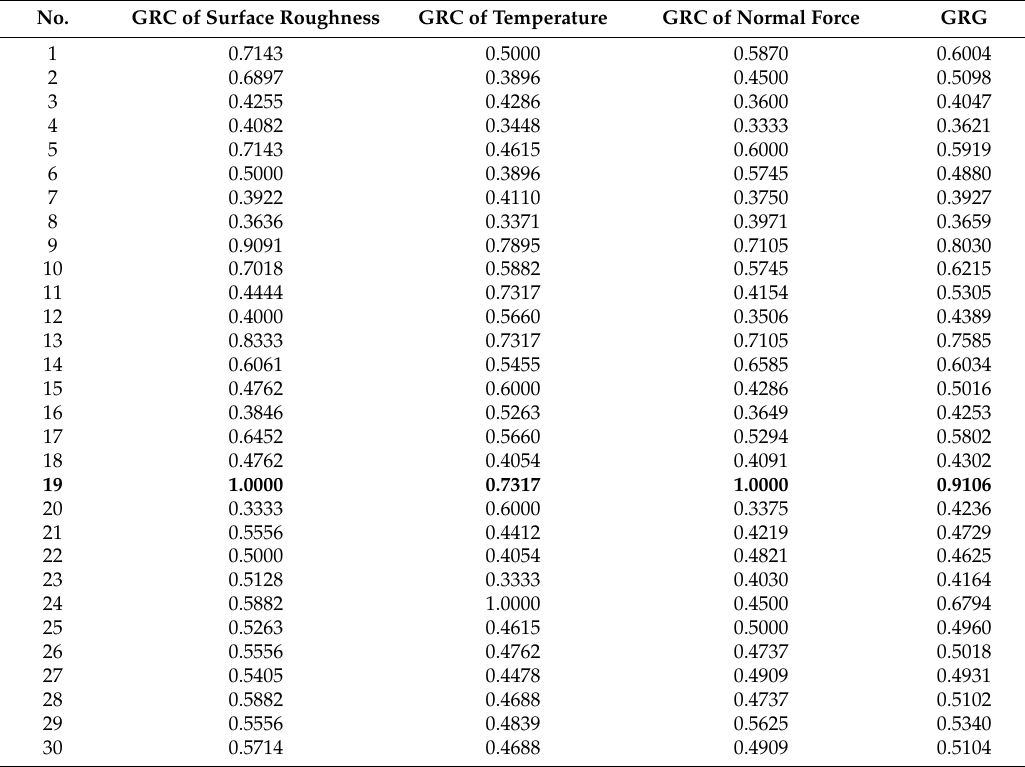
Bold indicates the optimum